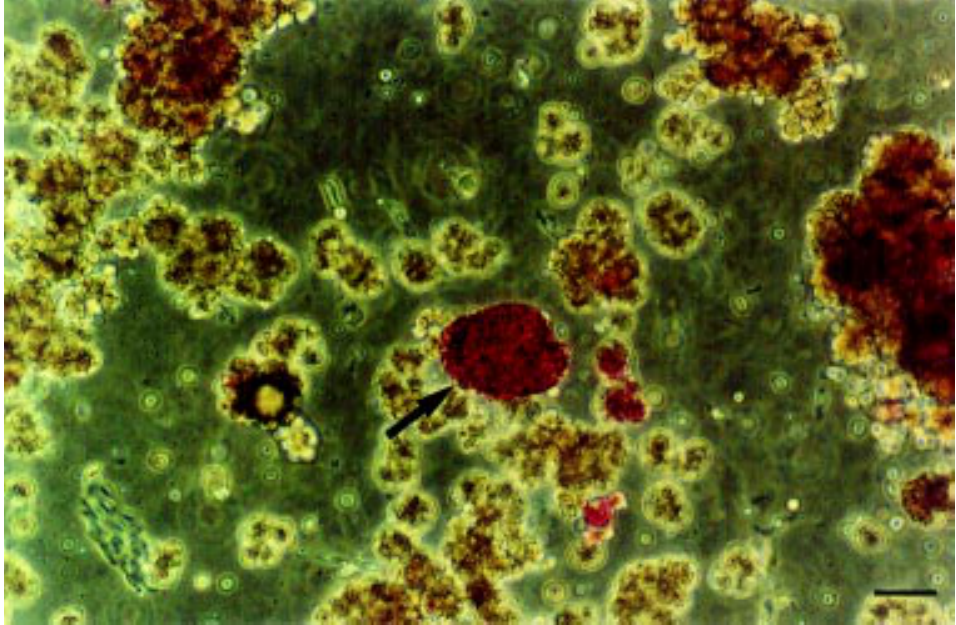
Figure 1. Human pancreatic is- lets (arrow) during the purifica- tion procedure, stained with dithizone, which specifically binds to zinc present in ß cell insulin granules. Bar: 100